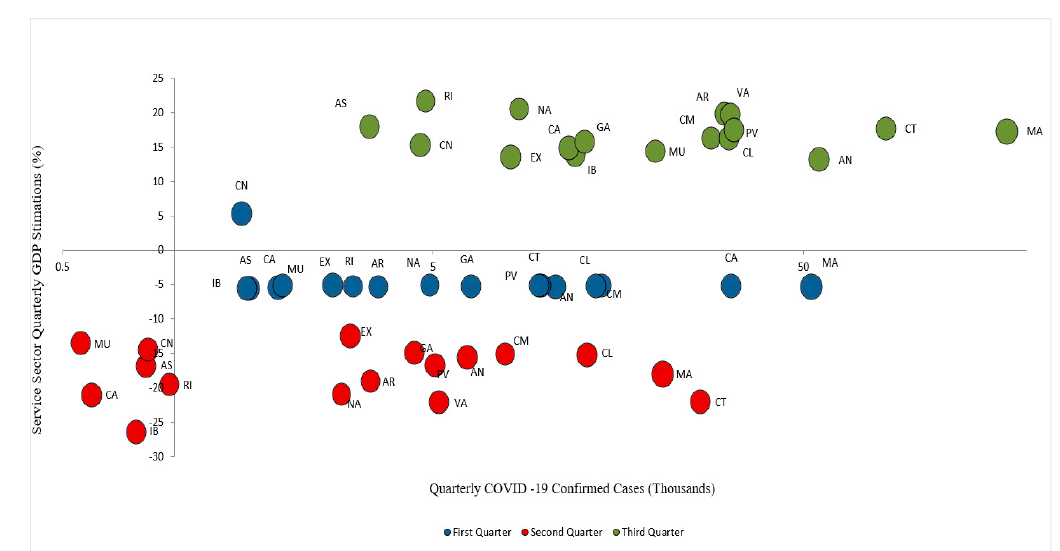
Figure 3. COVID-19 confirmed cases and GDP variations in Spain per region. AN: Andalucía; AR: Aragón; AS: Asturias; CA: Canarias; CN: Cantabria; CM: Castilla-La Mancha; CL: Castilla y León; CT: Cataluña; MA: Comunidad de Madrid; VA: Comunidad Valenciana; EX: Extremadura; GA: Ga- licia; IB: Islas Baleares; RI: La Rioja; NA: Navarra; PV: País Vasco; MU: Región de Murcia. Source: Own elaboration from SEPE, INE and CNE data.